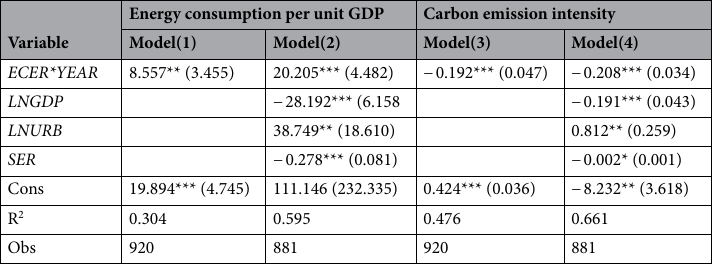
Table 4. Regression results of DID. In parentheses are standard errors, *, ** and *** indicate significance levels of 1%, 5% and 10%, respectively.